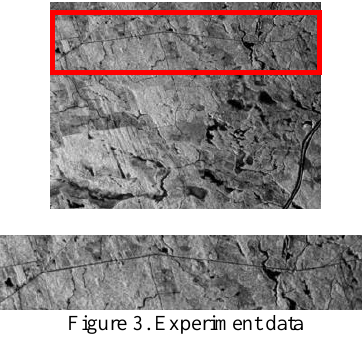
Figure 3. Experiment data